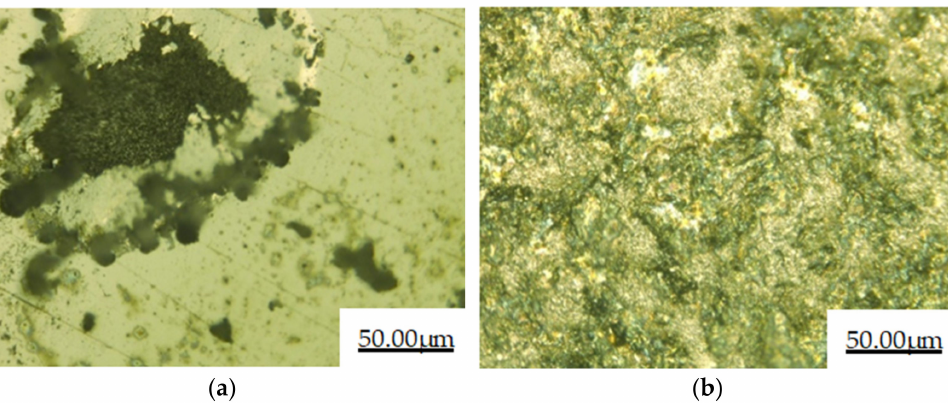
Figure 8. Electrochemical corrosion morphology of the ( a ) cladding layer and ( b ) 27SiMn